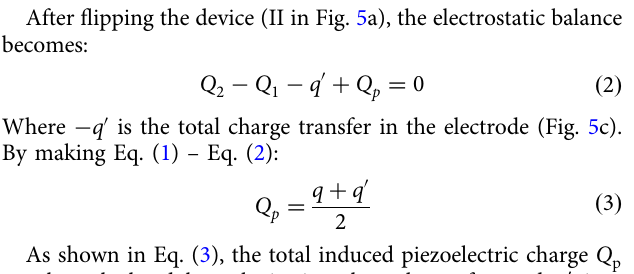
Extracting the piezoelectric charge transfer from “ piezo- electric ” output for piezoelectric performance evaluation . Here, we de fi ne Q as the piezoelectric charge transfer that induced by p PVDF fi lm at a certain force. Piezoelectric charges would accu- mulate with the increased force at the compressing stage and saturate in the compressed stage, fi nally getting released in the releasing stage. During the above stages, the saturated charge value at the end point of compressing stage (start point of . Based on above results and discussion, compressed stage) is Q p triboelectric charges and piezoelectric charges are saturated in the compressed stage as well as an electrostatic balance is formed, so we proposed a compressed balance analysis (CBA) method to extract piezoelectric charge transfer from the hybrid output. Speci fi cally, as shown in Fig. 5a (I), there is an electrostatic bal- ance between triboelectric charges and piezoelectric charges at the is the transferred charge in the Al plate, compressed stage. Q 2 (cid:1) Q